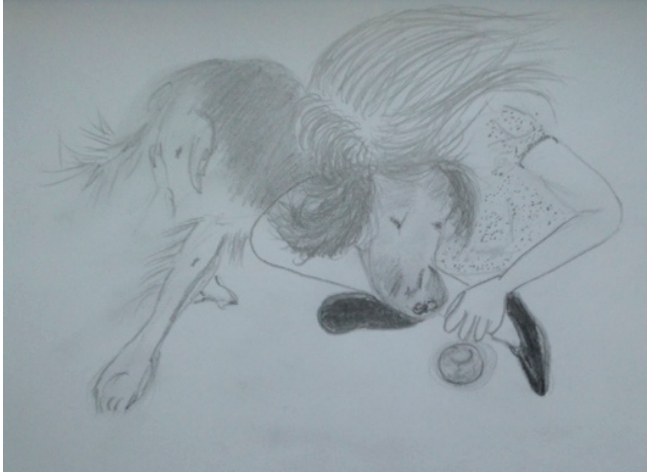
Figure 2. Jenny and Ted intimately intertwined in body. Animals 2019 , 9 , x